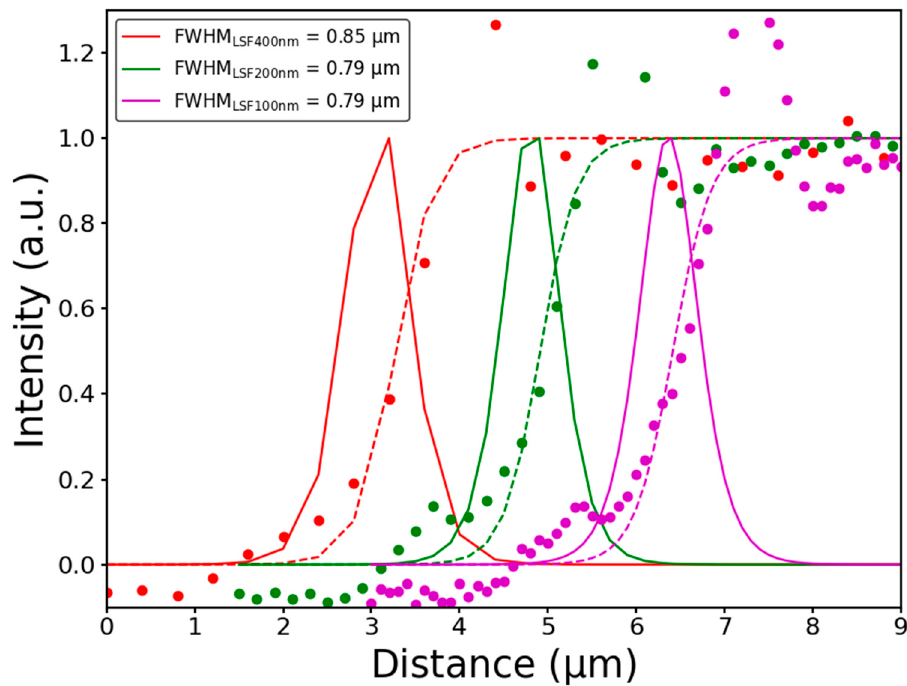
Figure 4. The measured ESF from a sharpened line pattern with steps of 400, 200, and 100 nm. The LSF has been fitted and illustrated with a solid line and has been normalized to unity. The peaks at the top of the sample profile correspond to the diffraction of the object. The raw curves correspond to the same sharp profile, but for easy visual understanding, they have been divided along the X-axis. The resolution calculated from the LSF is shown in the